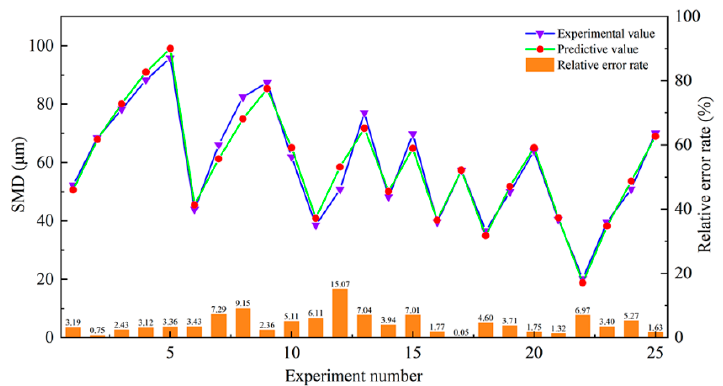
Figure 6. Comparison between the predicted values and orthogonal experimental values results of